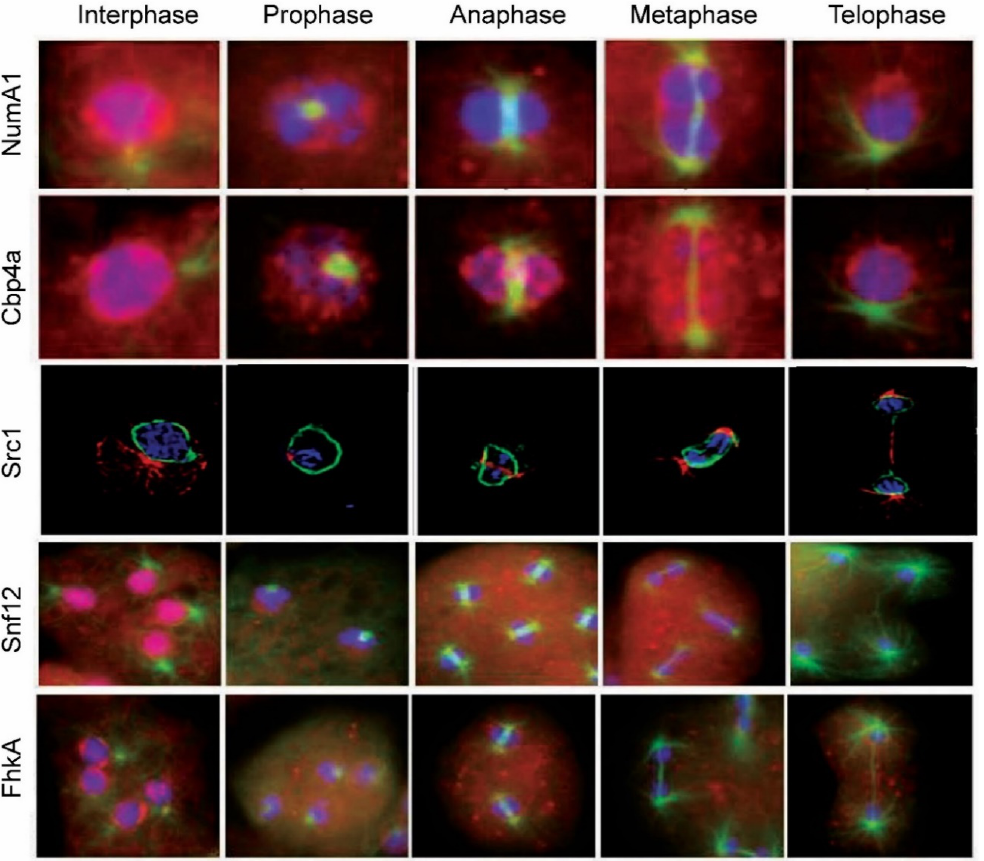
Figure 3. Nucleolar protein translocations during mitosis in Dictyostelium discoideum . NumA1, nucleomorphin A1, a cell cycle protein; Cbp4a, calcium-binding protein 4a, a NumaA1 binding protein; Src1, helix-extension-helix family homolog; Snf12, a nucleosome remodeling complex component; FhkA, a Rad53 (Chk2 in humans) tumor suppressor homolog. Note: the images for Src1 are from [72] with